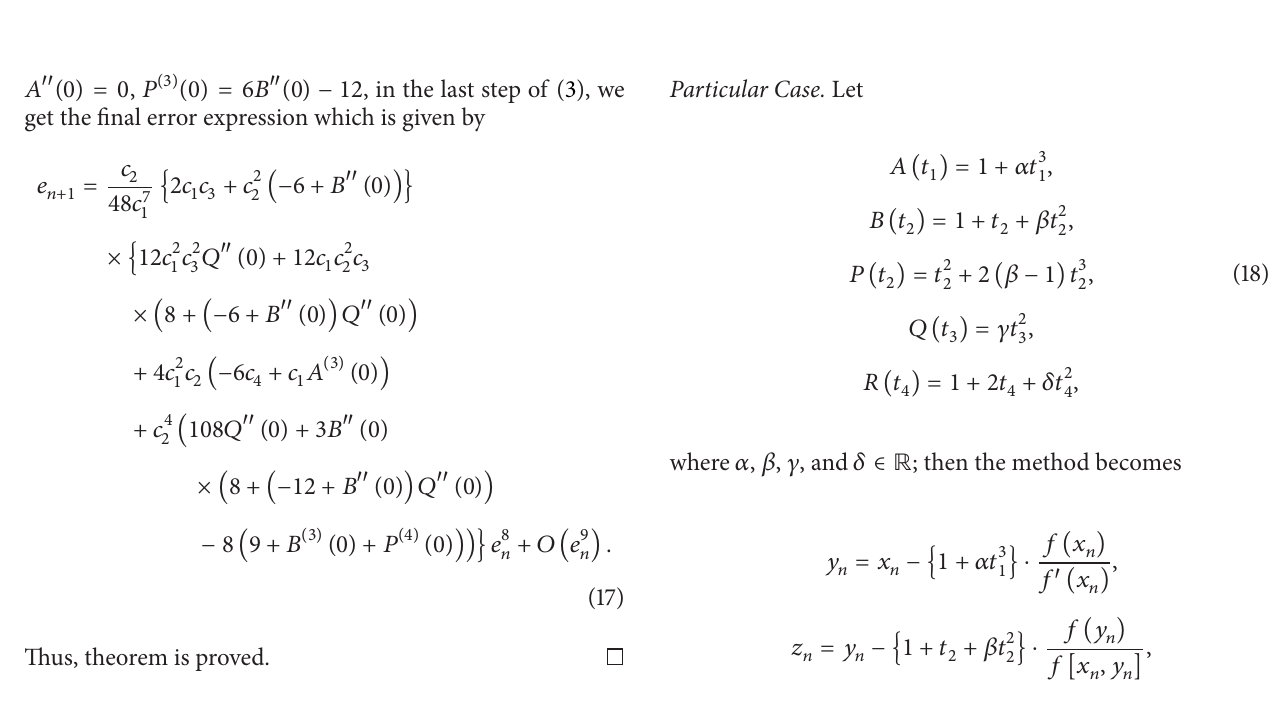
Figure 2: Basins of attraction for polynomial 𝑃 2 (𝑧) = (𝑧 3 + 4𝑧 2 − 10)